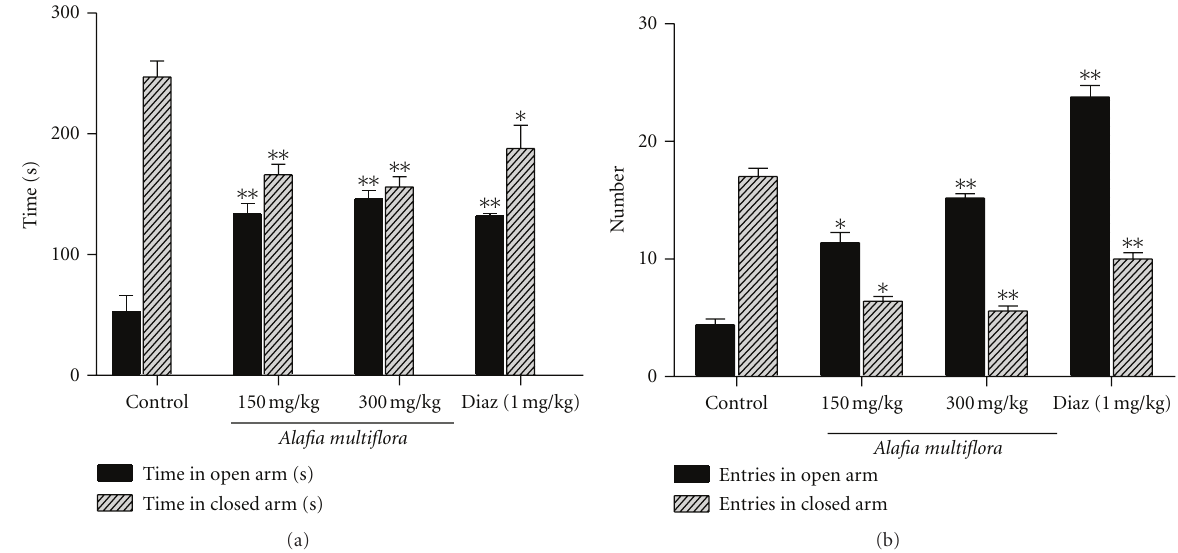
Figure 1: E ff ect of the aqueous extract of A. multiflora stem bark on the time spent in open and closed arms (a) and the numbers of entries in open and closed arms (b) in the elevated maze test. Experiments were performed 30min after the last chronic administration of the aqueous extract of A. multiflora or 30min after the single dose of diazepam (Diaz) administration. Data are expressed as mean ± SEM of 6 animals. ∗ P < 0 . 05, ∗∗ P < 0 . 01, compared to the vehicle-treated control group.